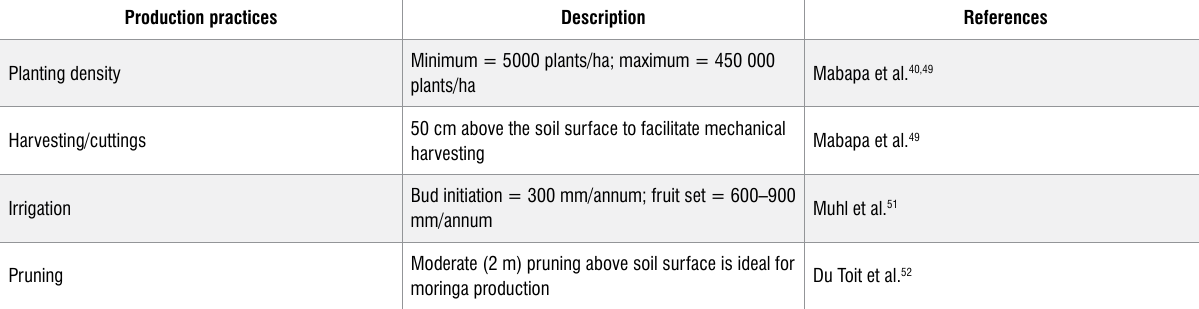
Cultivation practices and storage conditions as suggested by studies conducted within South Africa Production